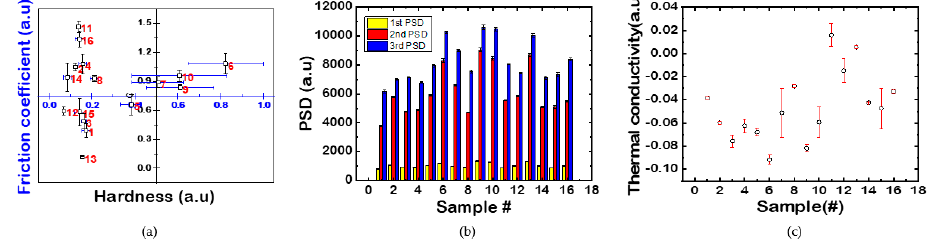
Figure 7. Mean and standard deviation data derived from 10 repeated measurements of 16 tactile samples for each indicator. ( a ) Hardness & Friction coefficient. ( b ) Roughness. ( c ) Thermal conductivity. Power Spectral Density (PSD) represents the contact energy. As the module moved horizontally while in contact with the texture sample, the magnitude (energy) of the de- tected signal from the sensor changed according to regular or irregular bumps on the sur- face of the sample. As such, this physical quantity is a good representation of the rough- ness of the surface of the object [14]. The first, second, and third PSDs were obtained by (FFT), categorizing signals into the low frequency domain (0~1 Hz, 1 st PSD), medium fre- quency domain (1~10 Hz, 2nd PSD), high frequency domain (10~20 Hz, 3rd PSD), very high frequency domain (20~250 Hz, 4 th PSD), and calculating the area of each frequency